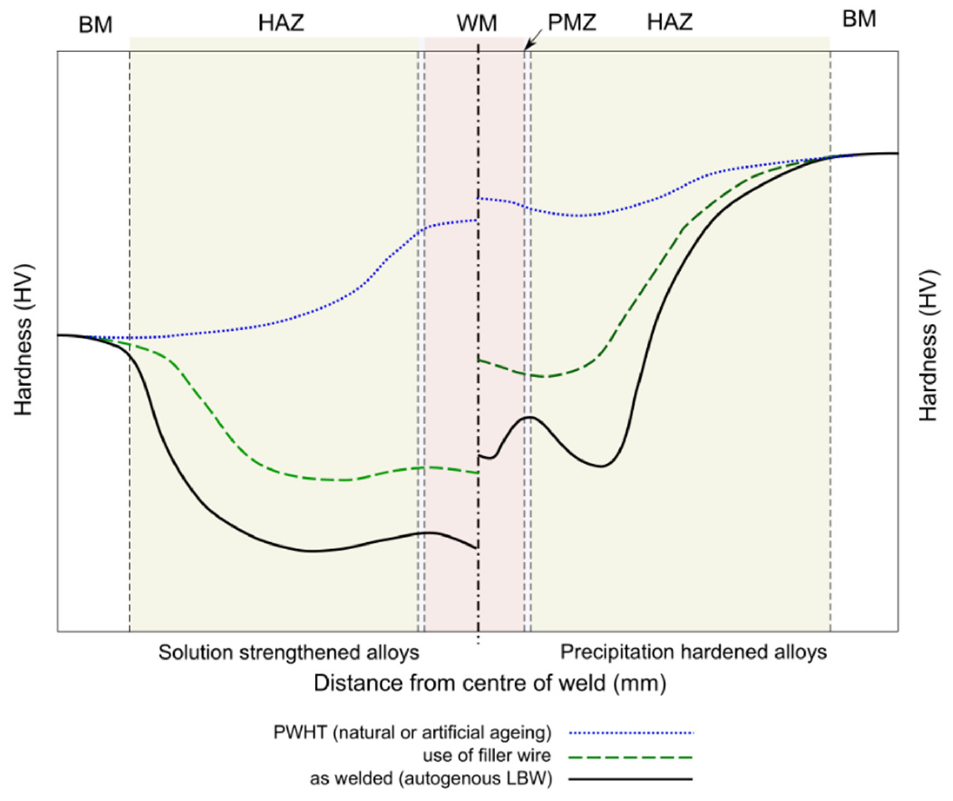
Figure 23. Hardness distribution in welding of aluminium alloys. Based on [8,18,33,97,100,164,169,174–177,183,188,195,214,229,256,264,271,282,284,306–322].